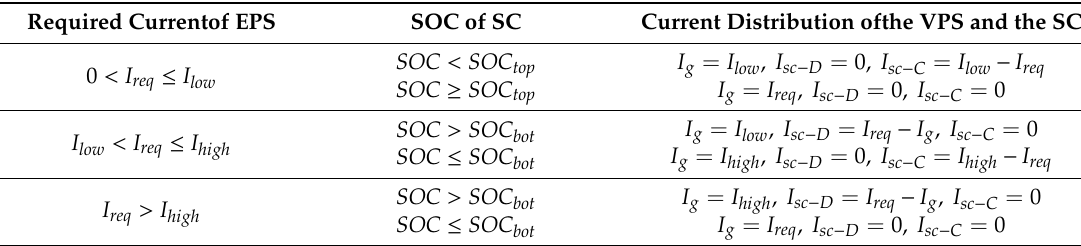
Table 1. The rule-based energy management strategy of